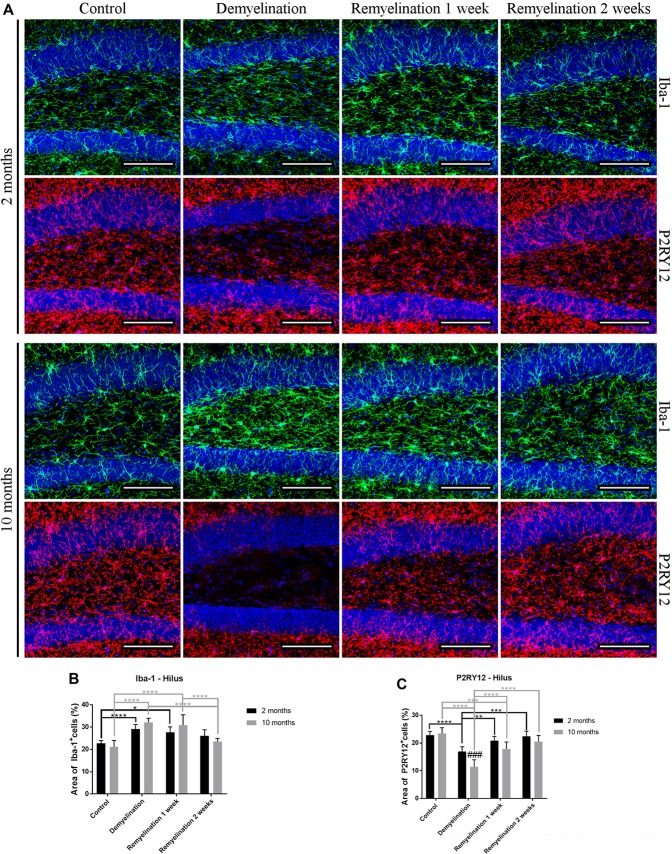
Different patterns of ionized calcium binding adaptor molecule 1 (Iba-1), and P2RY12 during de- and remyelination in the hilus of the DG. (A) Iba-1 (green) and P2RY12 (red) labeling. Cell nuclei are stained with 4′,6-diamidino-2-phenylindole dihydrochloride (DAPI; blue). (B) In both age groups, Iba-1 staining was significantly increased during demyelination until the first week of remyelination. (C) P2RY12 labeling was significantly decreased in both age groups during demyelination, and this was more pronounced and longer lasting in the middle-aged animals. Values are shown as means + SD (n = 6 per group). Statistical significance was evaluated using a two-way ANOVA and a Tukey’s post hoc test. The p-values are indicated in the graphs: treatment effects within the same age group: *p < 0.05, **p < 0.01, ***p < 0.001 and ****p < 0.0001, age-related differences: ###p < 0.001. Bars: (A) 100 μm.